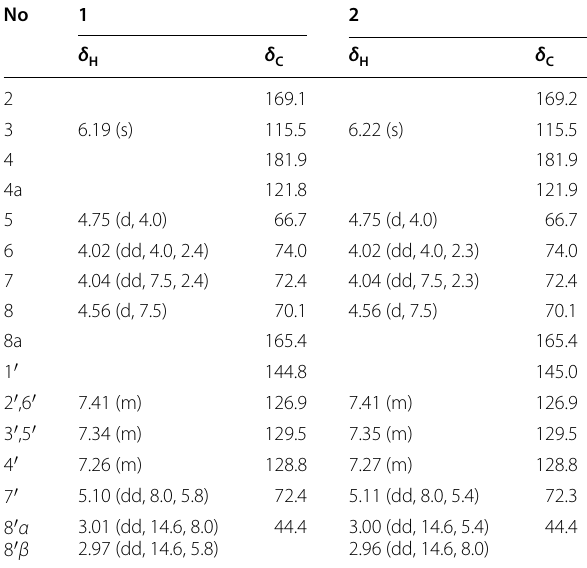
Table 1 1 H (500 MHz) and 13 C (126 MHz) NMR data of 1 and 2 in